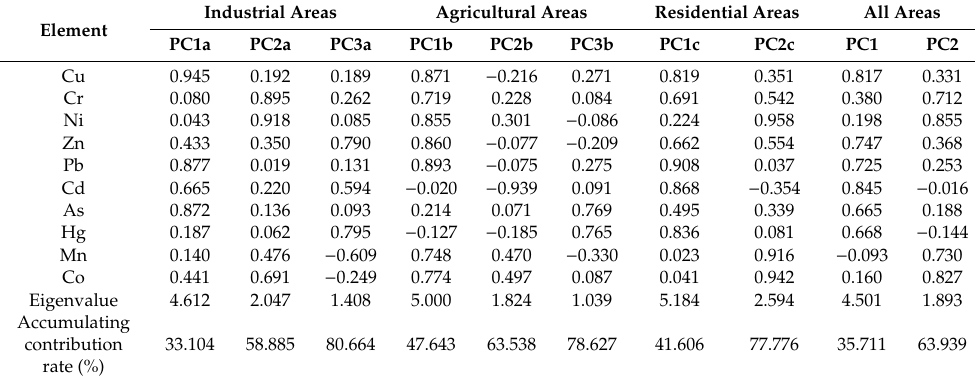
Table 5. Principal components (PC) of industrial areas, agricultural areas, residential areas, and all areas. Industrial Areas Agricultural Areas Residential Areas All Element